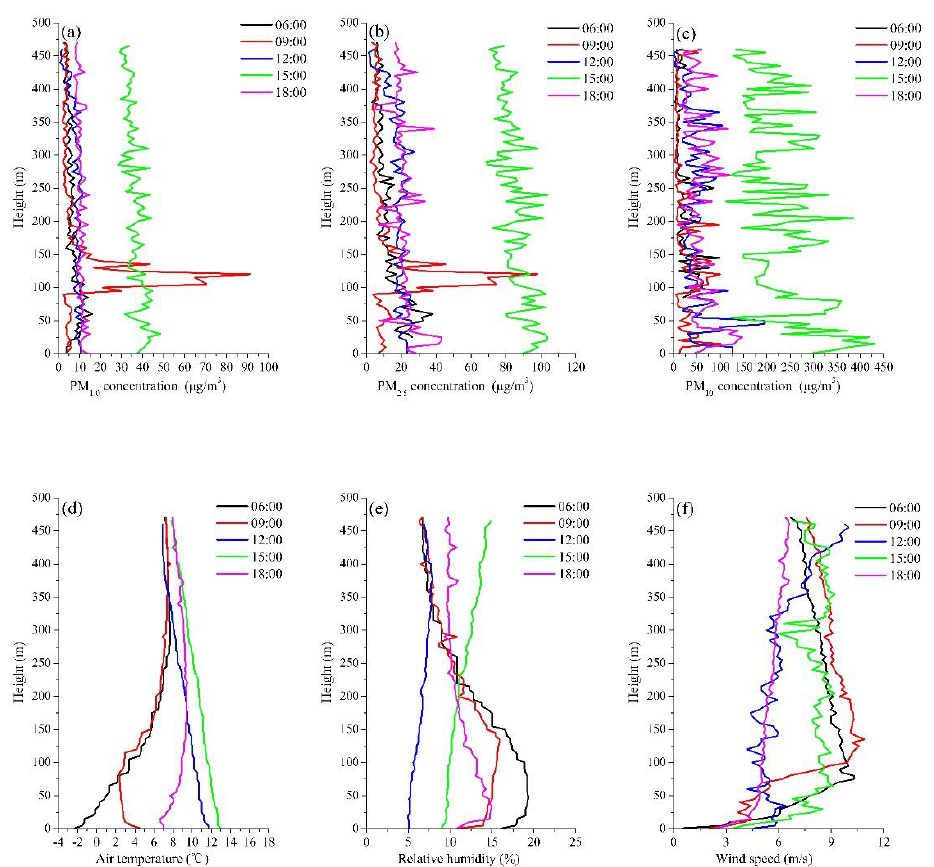
Figure 7. Vertical profiles of the PM 1.0 , PM 2.5 , and PM 10 concentrations ( a : PM 1.0 ; b : PM 2.5 ; c : PM 10 ) and the related meteorological parameters ( d : Air temperature; e : Relative humidity; f : Wind speed) in the boundary layer above Xiaotang during the observation periods (13 November was a floating dust day).